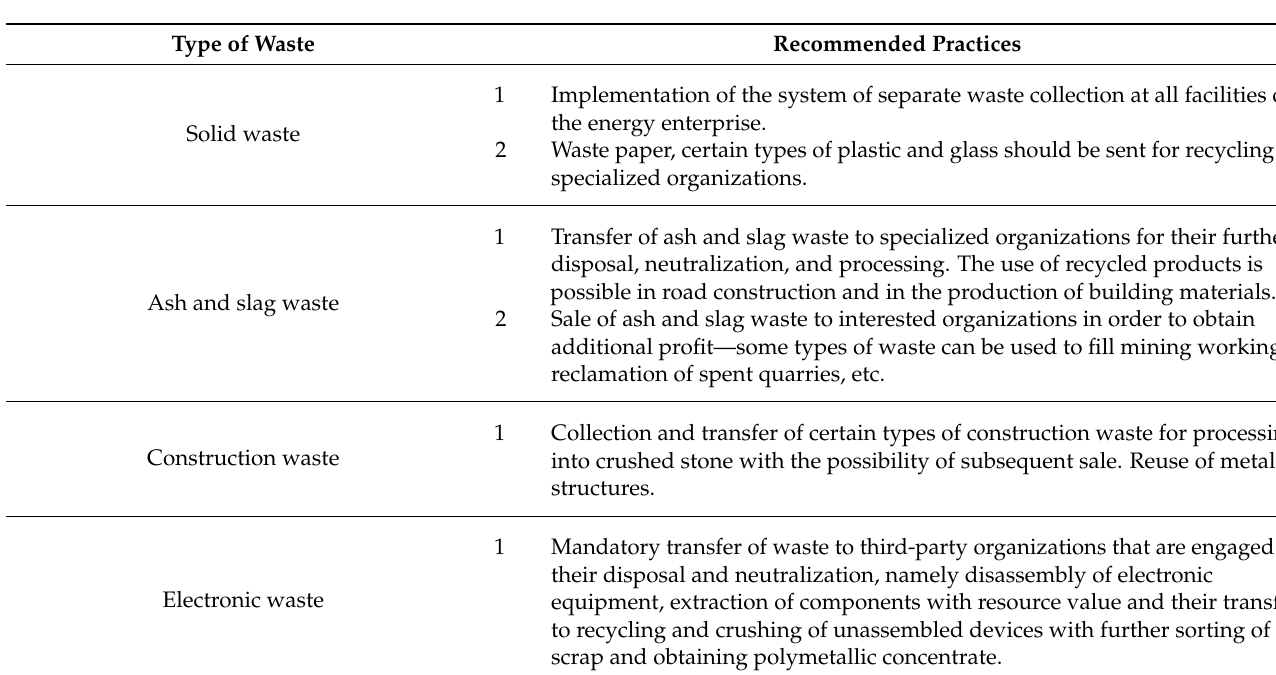
Table 3. Recommended waste management practices for energy facilities (made by the authors using data from